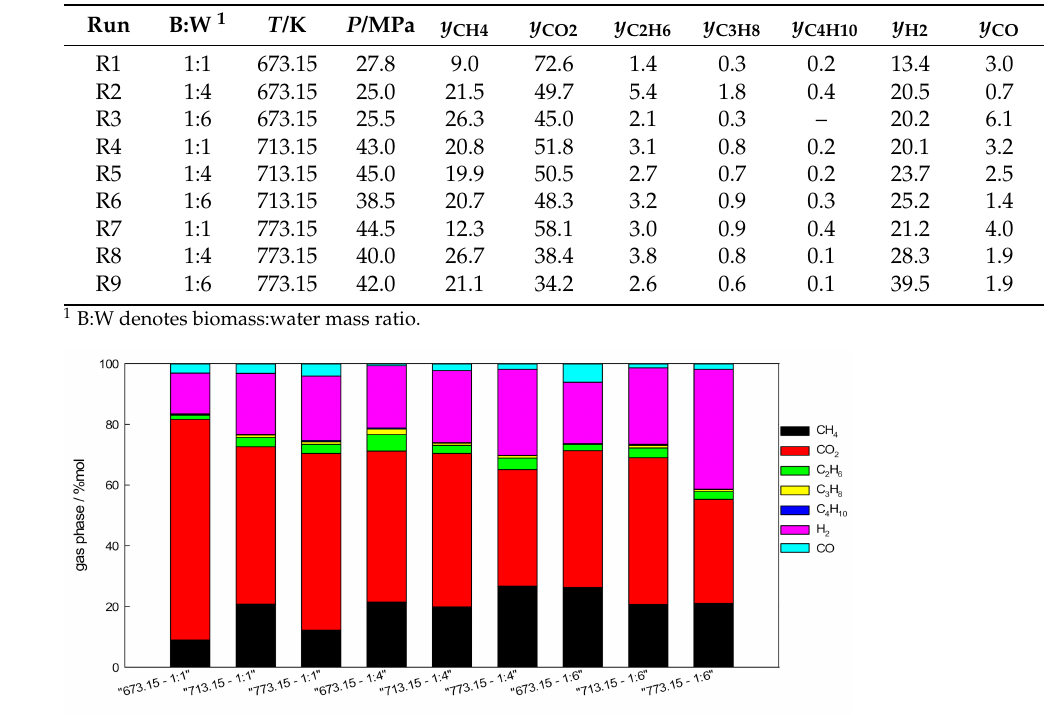
Table 3. Conditions for gasification reactions and gas product composition using supercritical water.